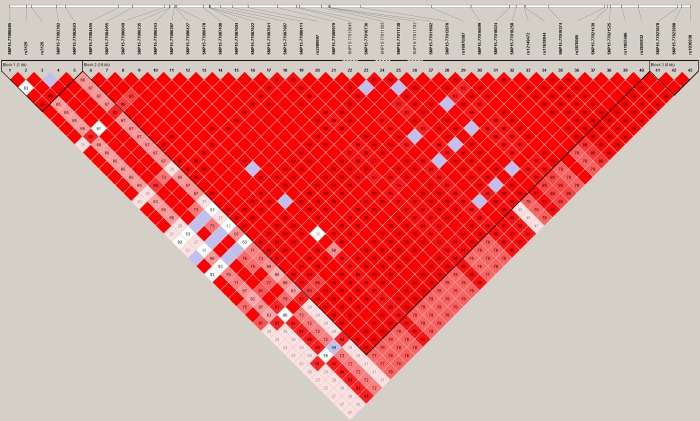
LD structure of CTSH in the DN dataset.The numbers in squares are D’. A standard color scheme in Haploview is used to display LD with bright red for very strong LD (LOD = 2, D' ≈ 1), white for no LD (LOD < 2, D' < 1), and pink (LOD = 2, D' < 1) and blue (LOD < 2, D' ≈ 1) for intermediate LD. [LOD, logarithm of odds].